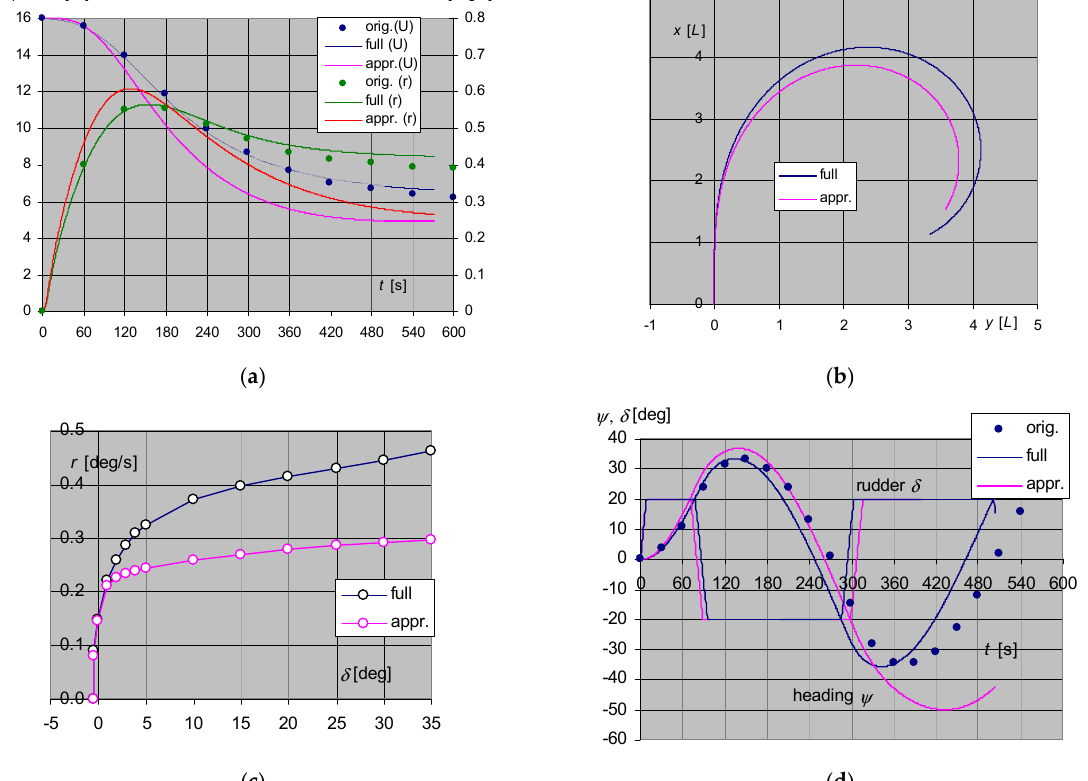
Figure A1. Selected standard manoeuvres of present ship model (with comparison towards original model: ( a ) turning circle test, 16 kn/20°, total linear speed ( U ) and rate of turn; ( b ) turning circle test, 16 kn/20°, trajectory x – y in ship’s length units; ( c ) spiral test at 16 kn; ( d ) Zig-zag test 20°/20° at 16 kn.